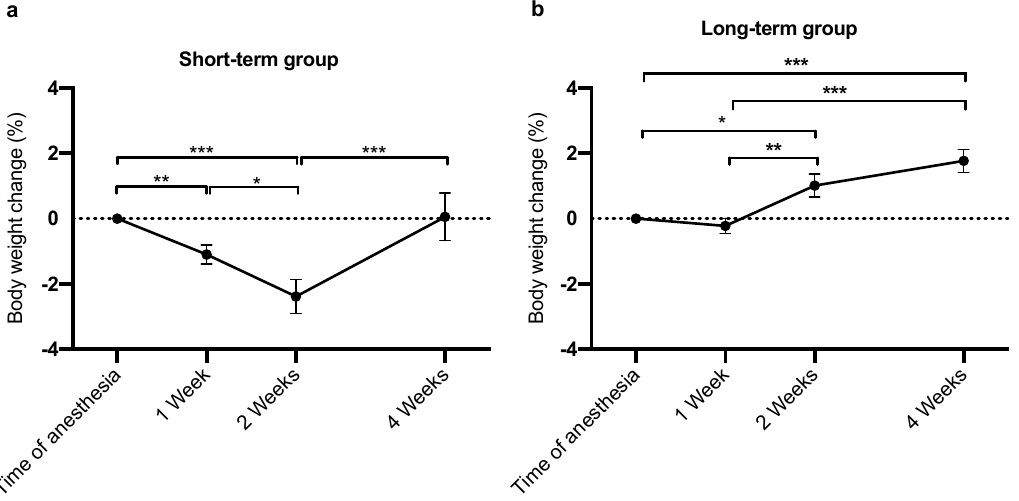
Figure 6. STG and LTG animals show different weight dynamics after anesthesia. ( a ) Animals in the STG ( n = 5) displayed a significant decline in body weight 2 weeks after anesthesia compared to baseline ( p = 0.0012), which was compensated only 4 weeks after anesthesia ( p = 0.0012). ( b ) Body weight of animals in the LTG ( n = 4) showed only negligible weight loss after anesthesia, which was fully compensated the following week and further increased until 4 weeks after anesthesia ( p = 0.0004). Data are presented as mean ± SEM. * p < 0.05; ** p < 0.01; *** p < 0.001.